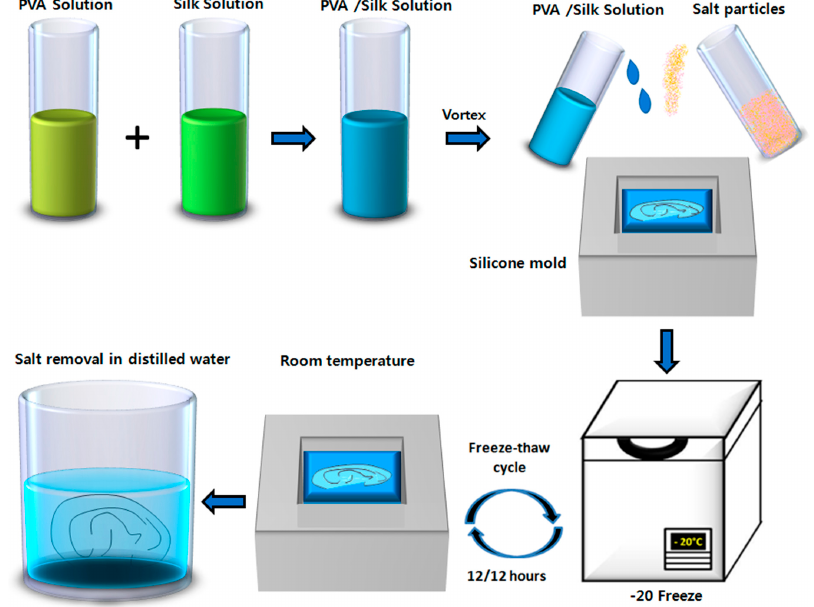
Figure 9. Schematic representation of the process for ear-shaped hydrogel fabrication. PVA and